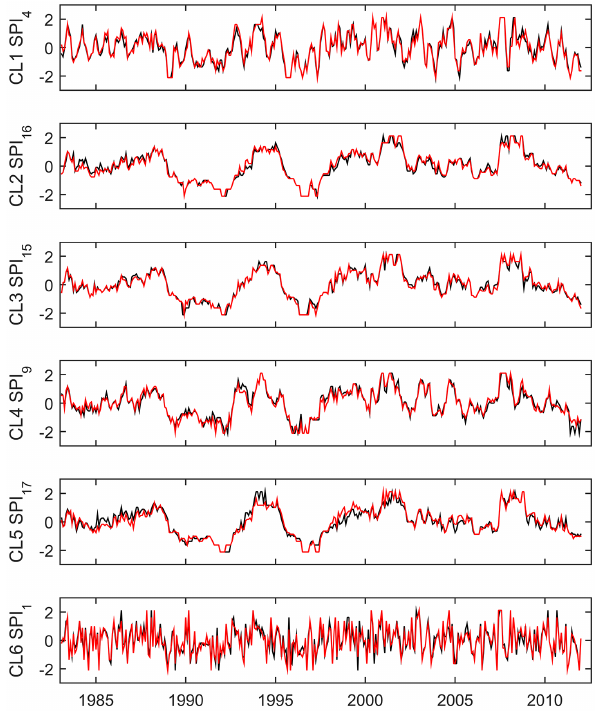
Figure 7. Mean SGI time series for each of the six k -means